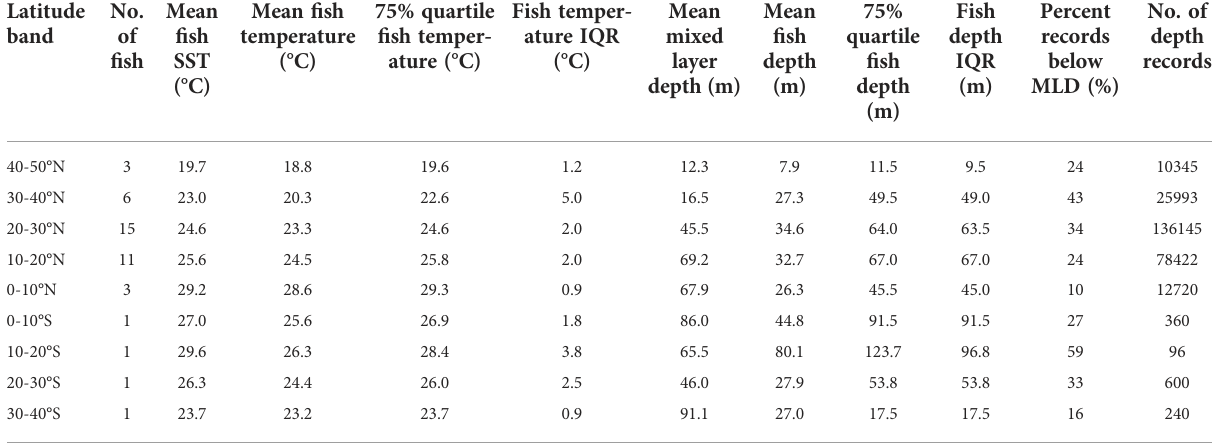
TABLE 3 Depth occupied and temperature experienced by striped marlin summarized by 10°-latitude bands. Latitude band